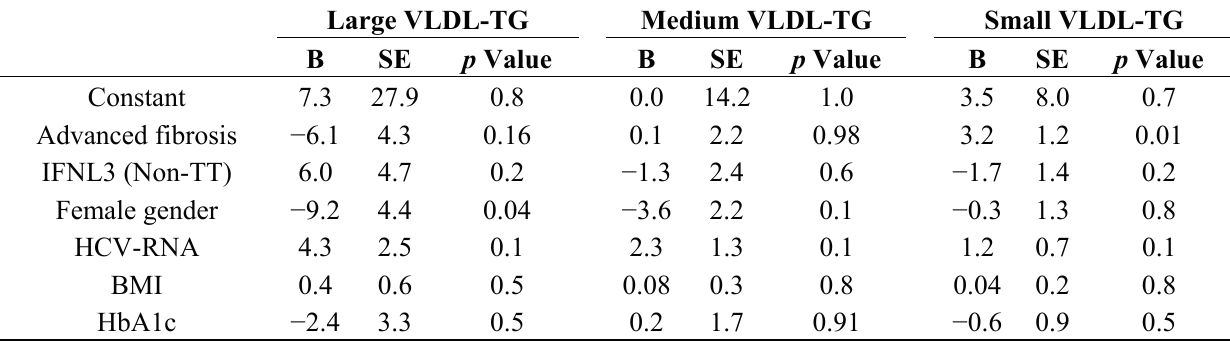
Figure 6. Comparison of the distribution of TG in VLDL sub-fractions between patients with advanced fibrosis and those with mild-moderate fibrosis (Adv; advanced, Mod; moderate, * p < 0.05; ** p < 0.01). Table 6. Impact of advanced fibrosis on the distribution of TG in VLDL sub-fractions analyzed using multiple regression